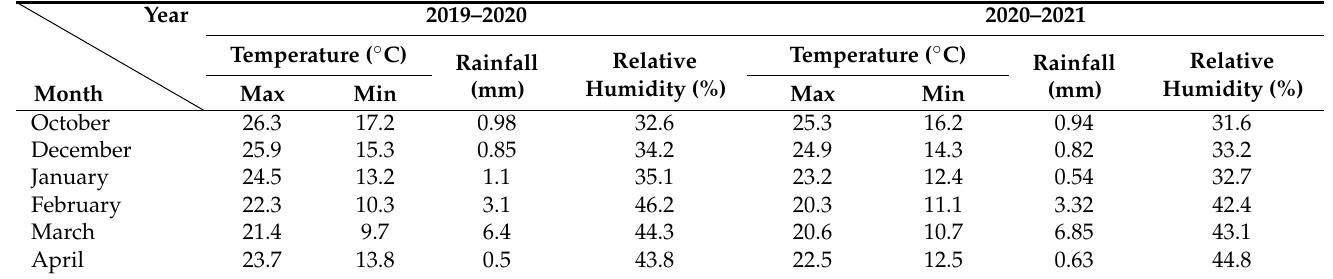
Table 5. Meteorological data of the experimental sites during 2019–2020 and 2020–2021 growing